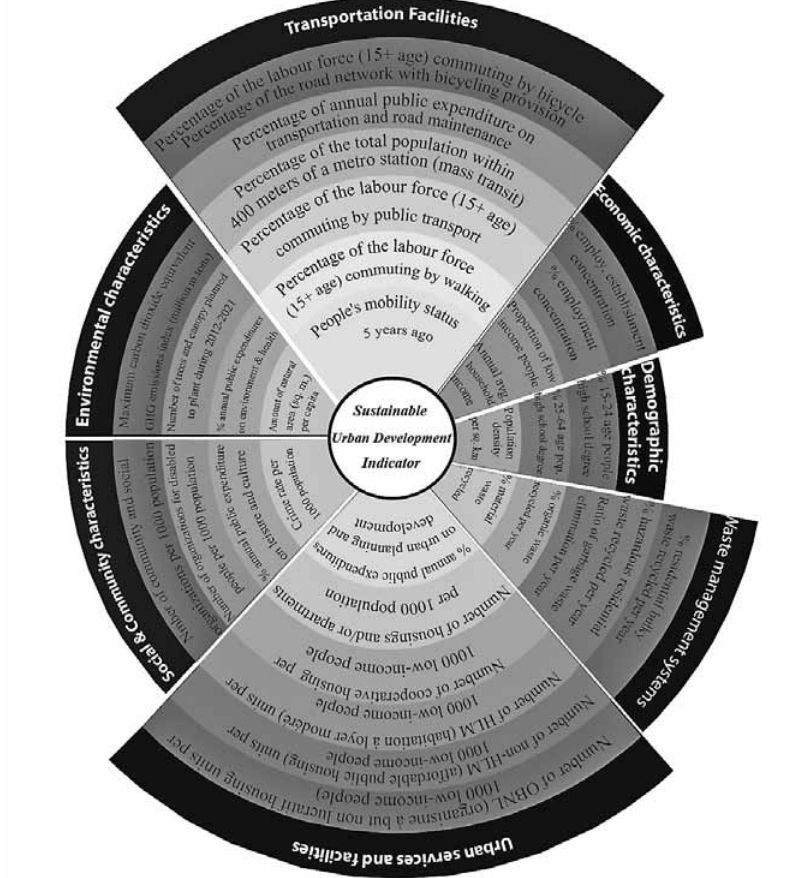
fig. 1. Variables of sustainable urban development